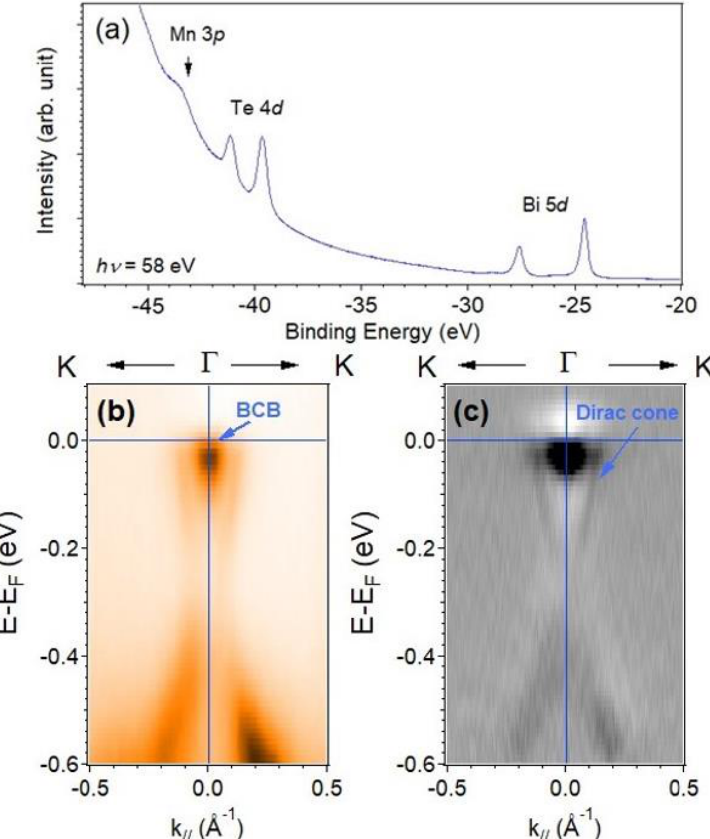
Figure 4. ( a ) The XPS spectrum of MnBi 2 Te 4 with photon energy 58 eV. ( b ) The band-mapping result of a MnBi 2 Te 4 sample measured at 80 K along direction Γ -K with photon energy 24 eV. ( c ) The second derivative of ( b ) to enhance the visibility of a Dirac cone.